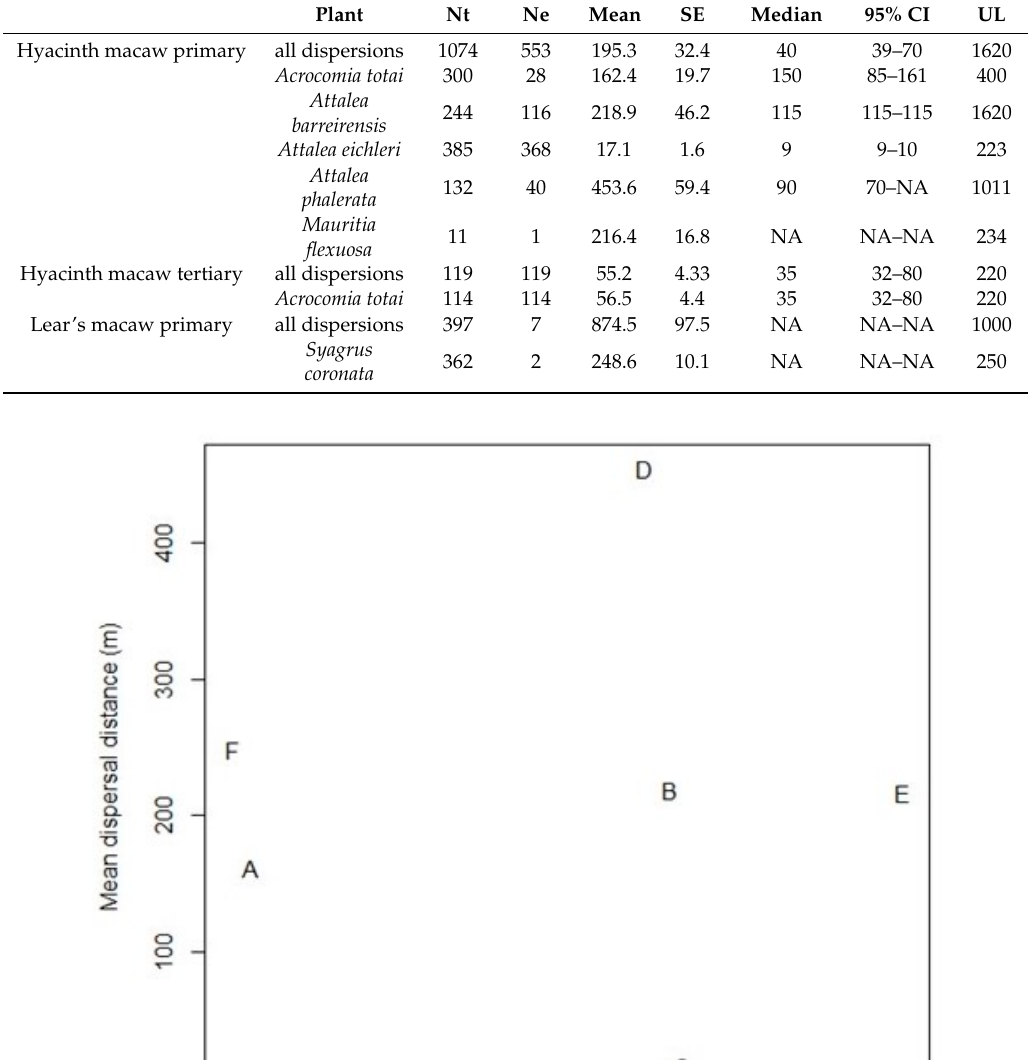
Table 3. Estimated mean ( + SE) and median (95% CI) dispersal distances for all primary and tertiary dispersal events and each palm species, indicating the total number of recorded dispersal distances (Nt), the number of recorded exact distances (Ne), and the upper limit (i.e., the maximum distance observed) used for calculating the mean dispersal distance for each species (UL).